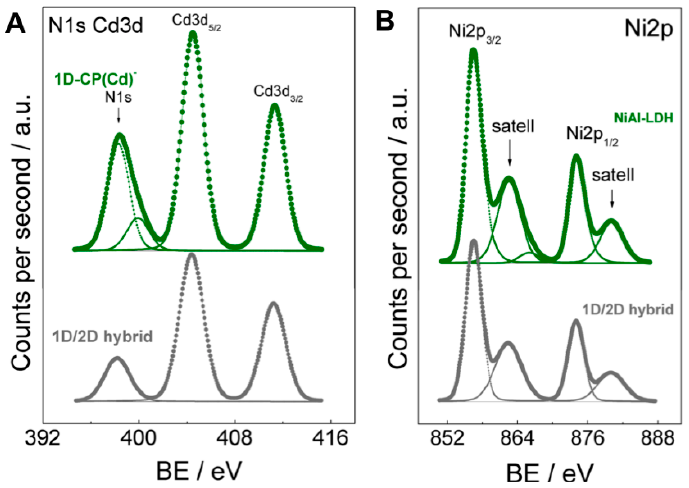
Figure 4. N1s and Cd3d ( A ); and Ni2p ( B ) core-level spectra of 1D-CP(Cd) , NiAl–LDH and 1D/2D hybrid samples.